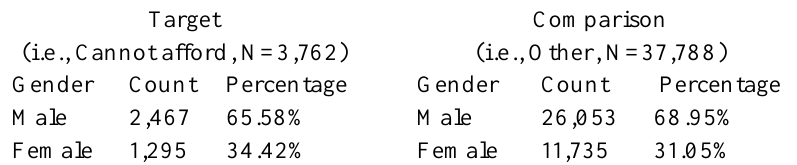
Gender Breakdown for Learners in the Target vs. Comparison Groups